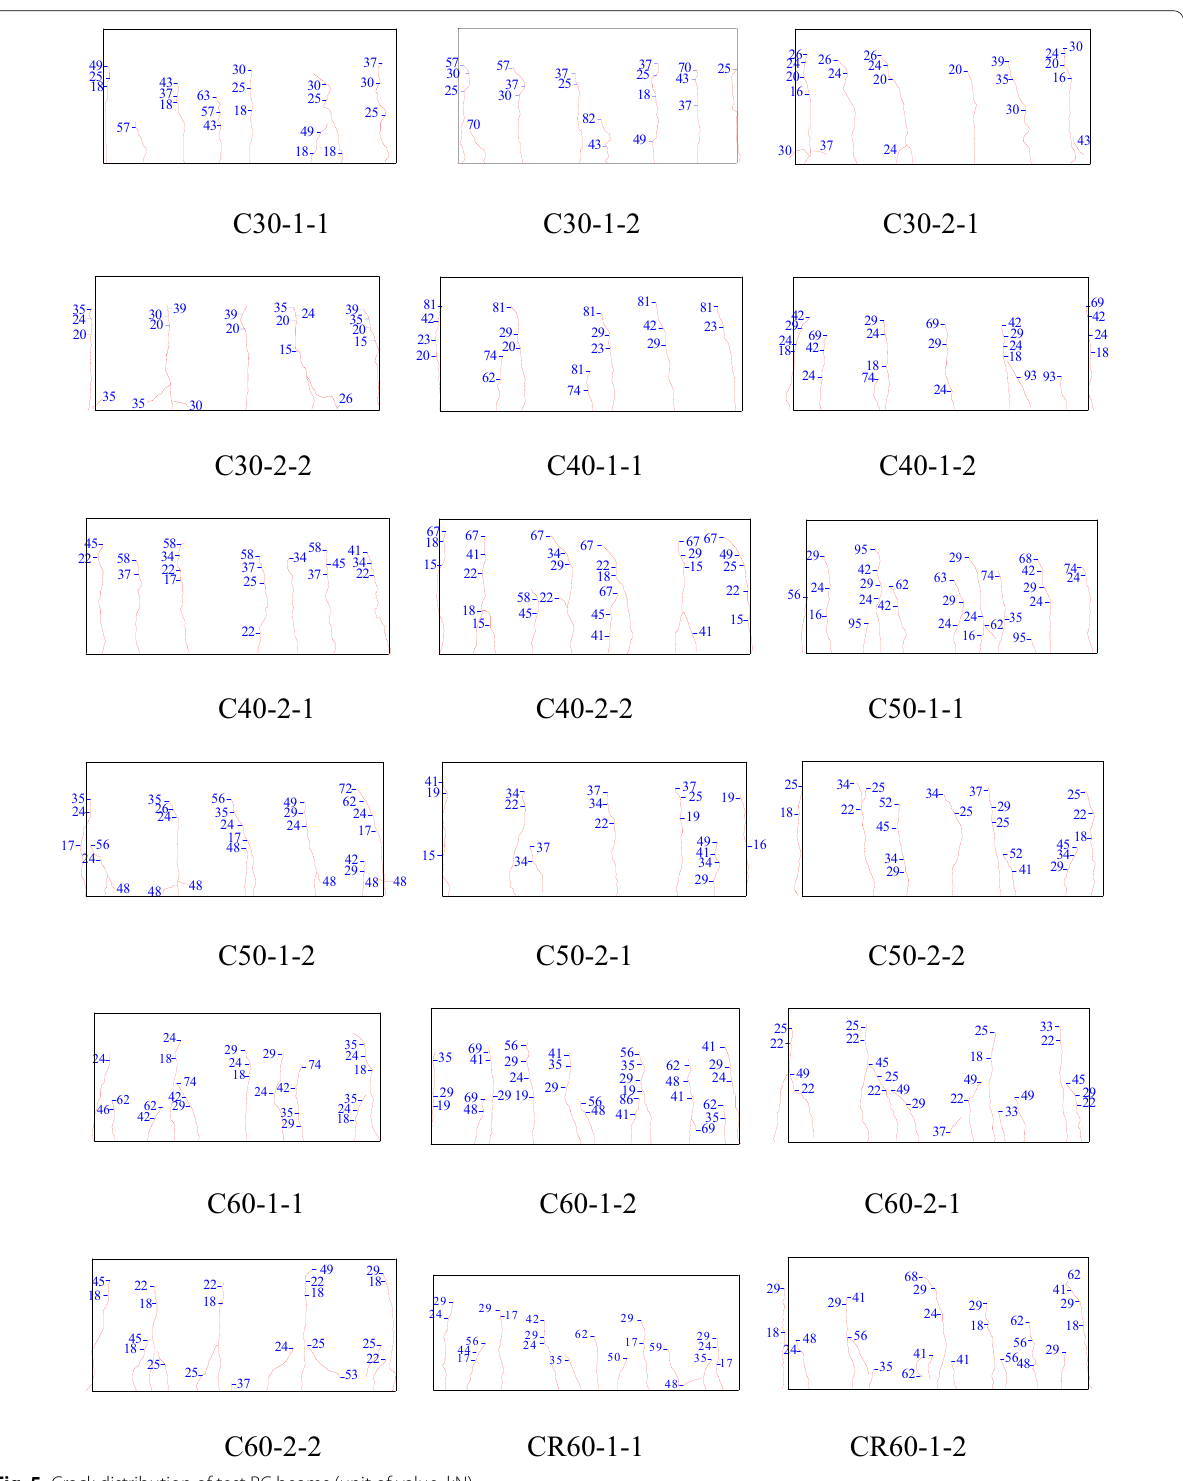
Fig. 5 Crack distribution of test RC beams (unit of value: